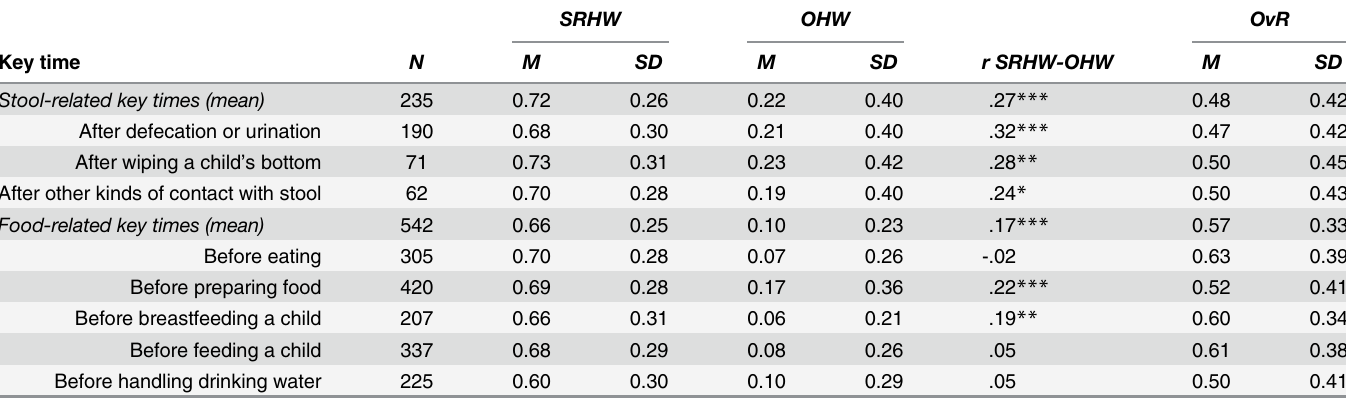
Table 1. Descriptive statistics and Pearson correlations for self-reported and observed handwashing and descriptive statistics for over-reporting at key